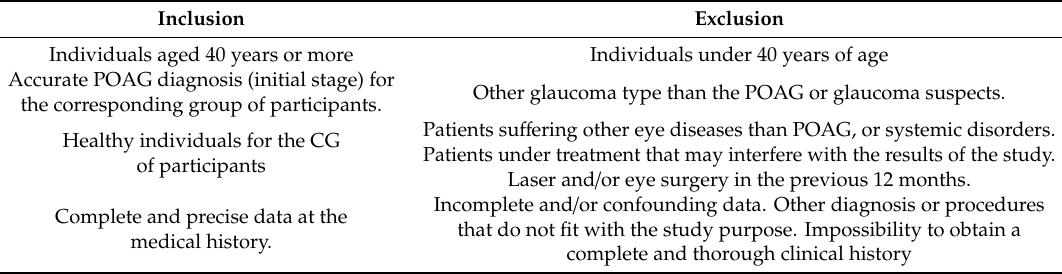
Table 1. Inclusion and exclusion characteristics for the study